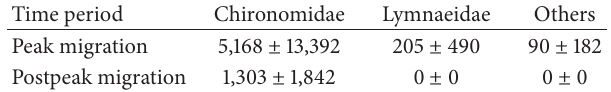
Table 1: Mean ± SD benthic macroinvertebrate densities from the counts at Wuliangsuhai Lake during the autumn migration in 2011 ( 𝑛 = 33 ).